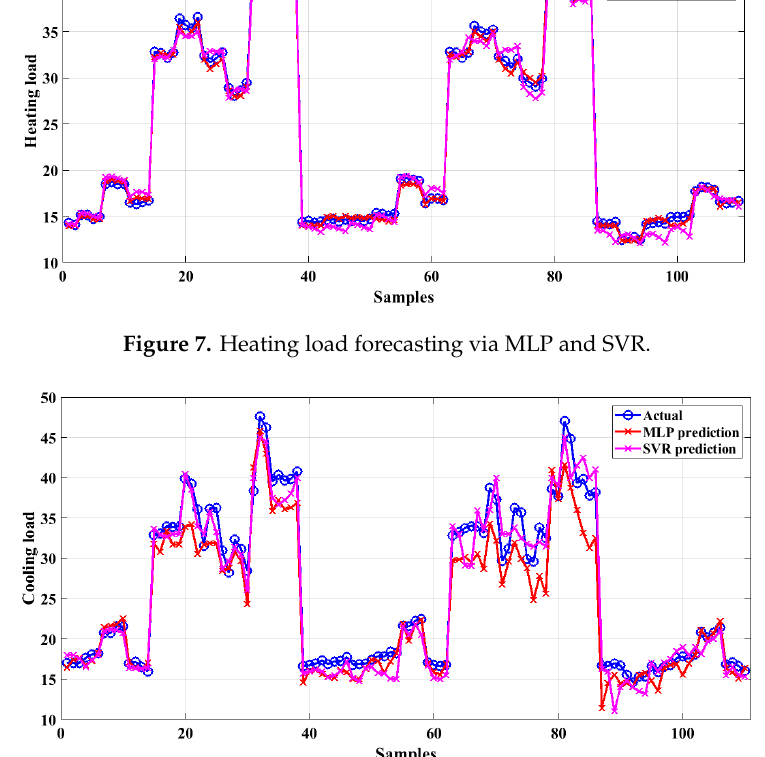
Figure 8. Cooling load forecasting via MLP and SVR.